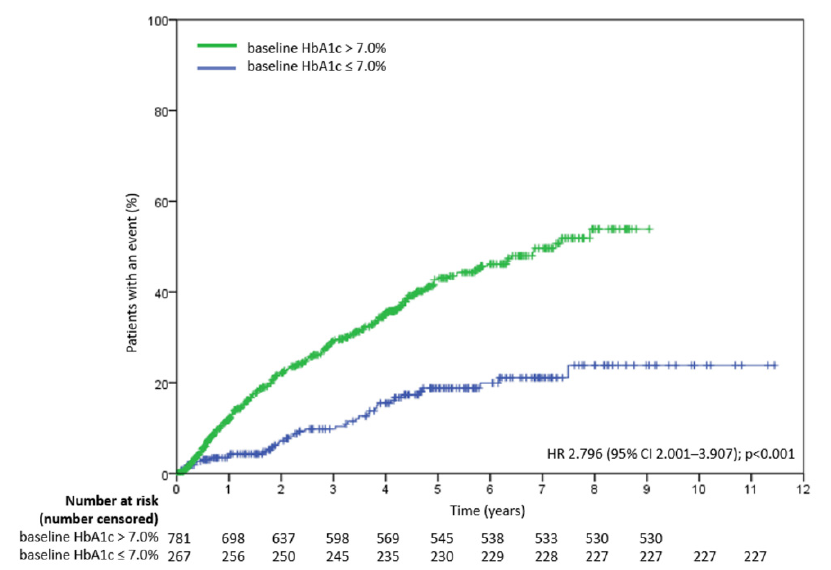
Figure 3. Time to treatment failure in two cohorts: baseline HbA1c > 7.0% and ≤ 7.0%. HR is based on Cox regression analysis. HR = hazard ratio. 3.3. Determinants of Treatment Failure in Study Patients with Baseline HbA1c > 7.0% Table 3 displayed determinants of treatment failure using forward Cox proportional hazards regression analysis in study patients with baseline HbA1c > 7.0% (n = 781). In patients with baseline HbA1c > 7.0%, after multivariable adjustment, young age ( p < 0.001), elementary school or uneducated (vs. university or higher, p = 0.007), high glycemic burden AUC’ (per 1%/90 days; HR, 1.026; 95% CI, 1.018 to 1.034; p < 0.001), AGIs use ( p = 0.048), and baseline HbA1c (per 1%; HR, 1.130; 95% CI, 1.058 to 1.171; p < 0.001) were significantly associated with treatment failure in study patients with baseline HbA1c >